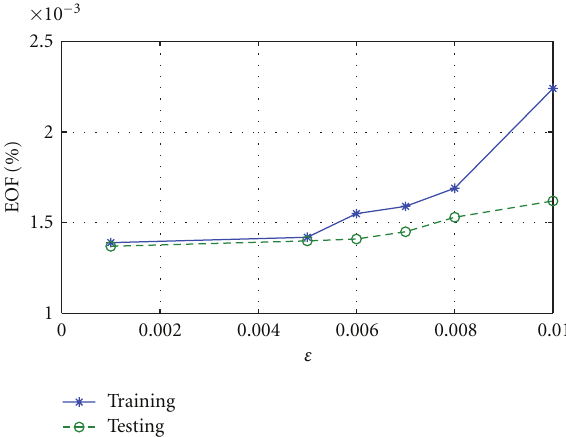
Figure 8: Dimension I of trained dictionary G decreases on all three axis as ε increases.